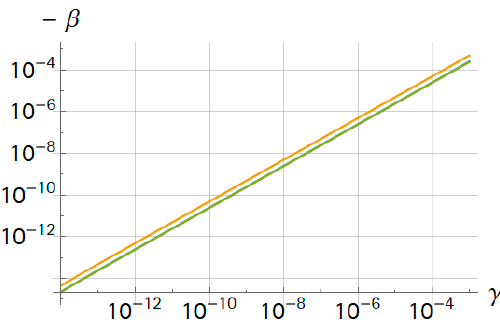
Figure 9. Relative frequency changes ( − β ) due to the mass ratio ( γ ) for the equivalent model. The used parameters were m = 1 kg; m n = γ m ; k = 10 N/m; M = m / κ ; k M = k / κ ; κ = 10 − 4 ; D = d M = 5 × 10 − 4 Ns/m; C p = 10 nF; and α = 0.1 N/V.